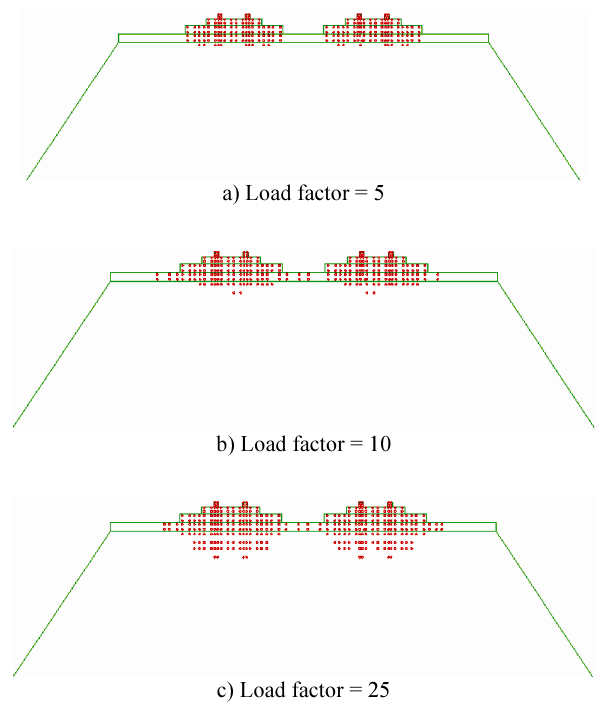
Fig. 9. Yielding behavior with different load